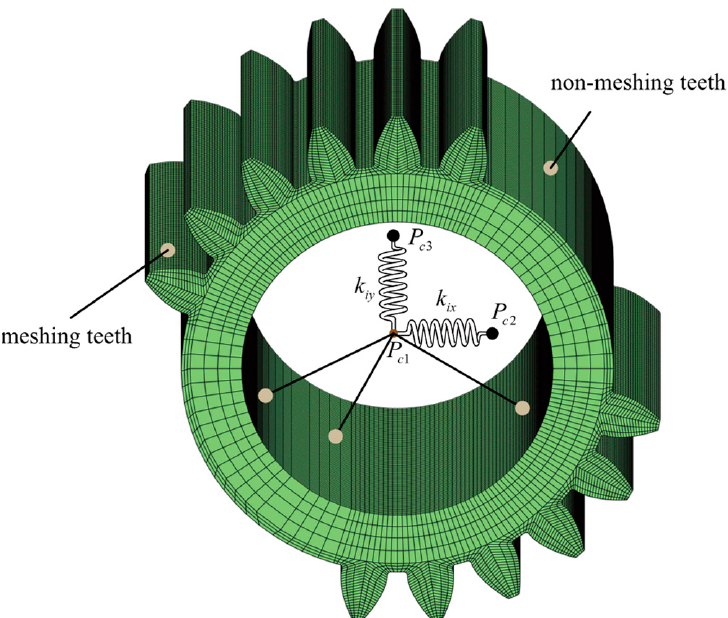
Figure 5. Schematic diagram of the pinion finite element model.